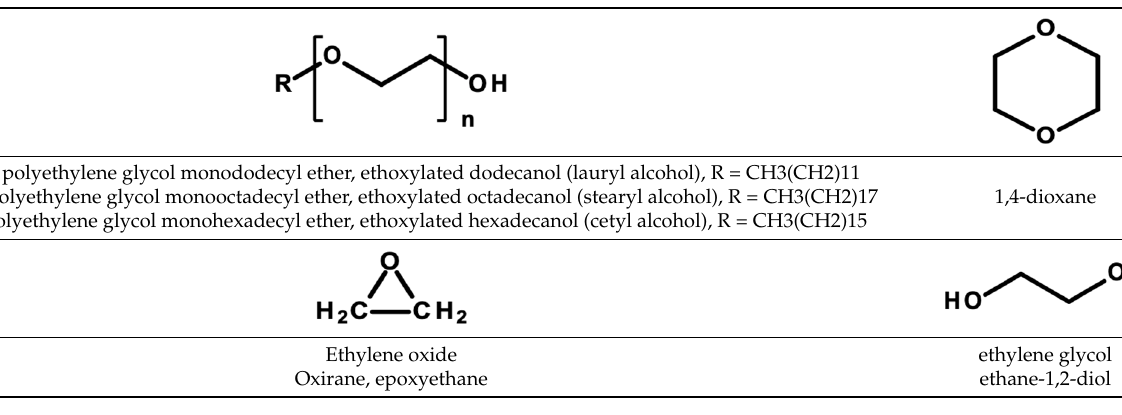
Table 7. Chemical structure of ethoxylated compounds.